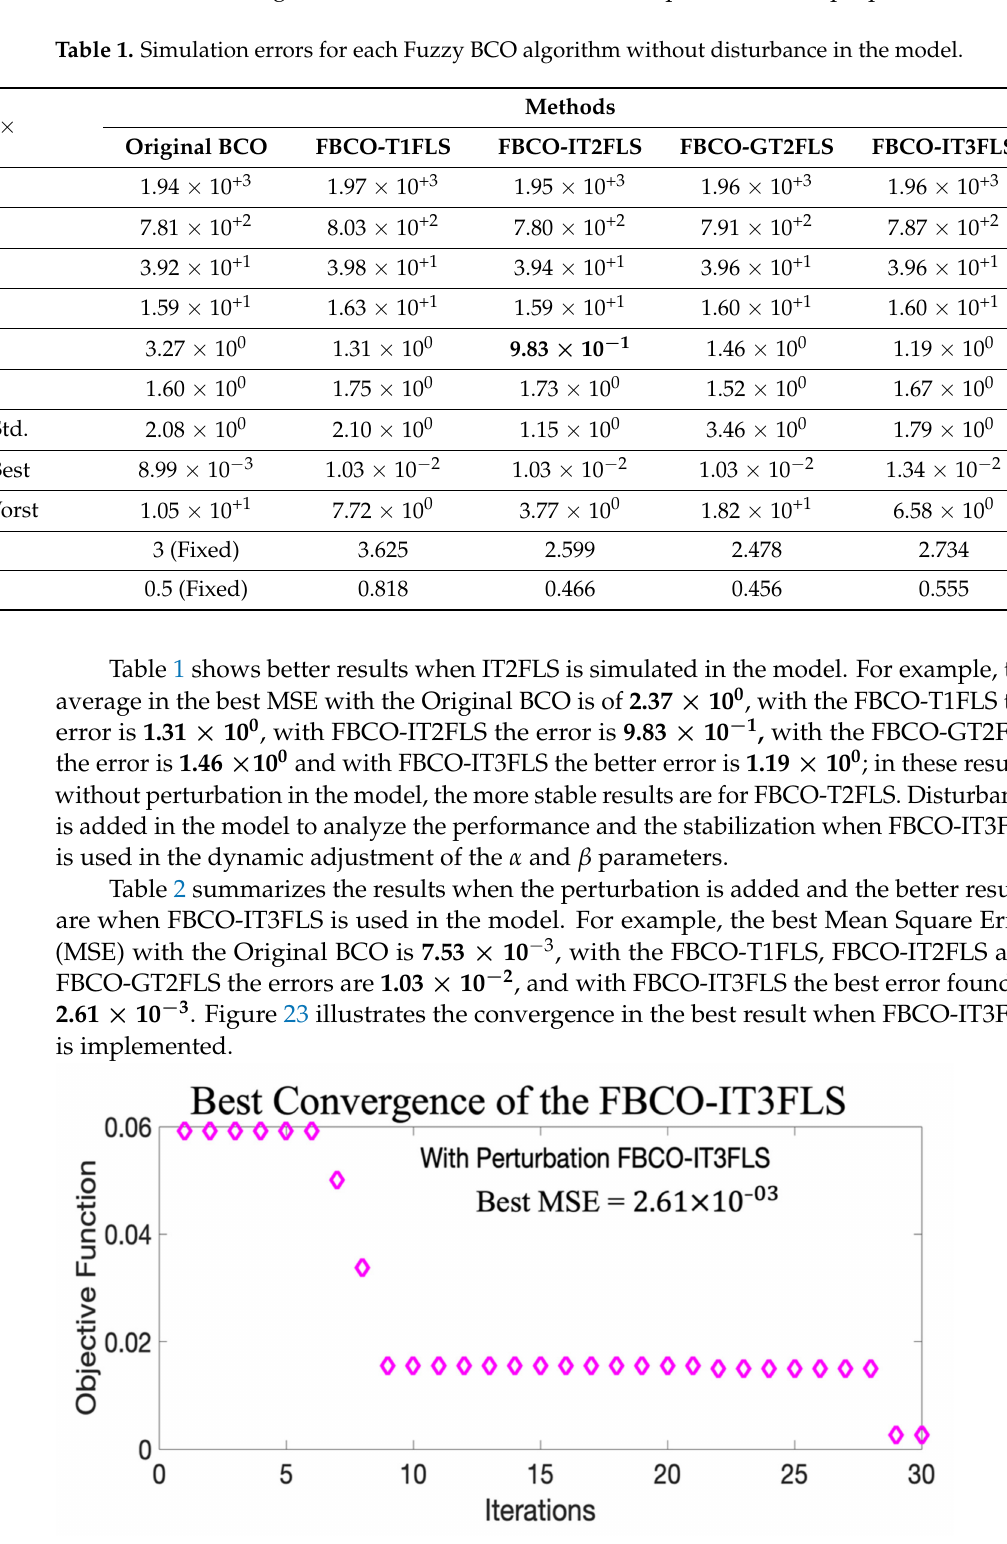
Figure 23. Best convergence with the proposed Fuzzy BCO with